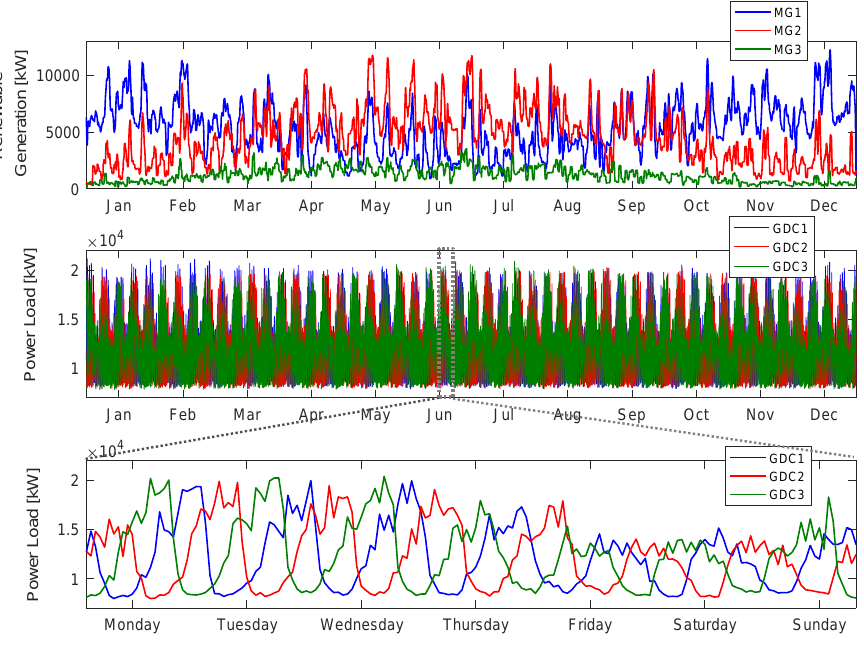
Figure 4. 24-day simple moving average of renewable power generation (top graph) and hourly GDC load demands for a year (middle graph) and a week (bottom graph) for the three microgrids in the case study.